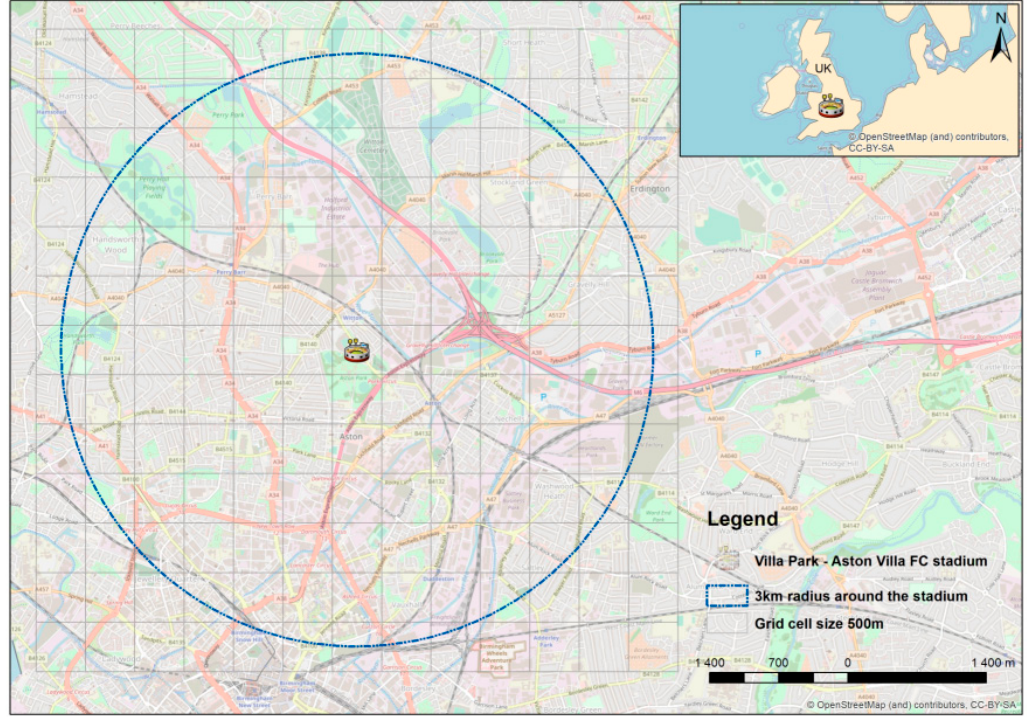
Figure 1. Study area of Aston Villa stadium, Birmingham, UK.